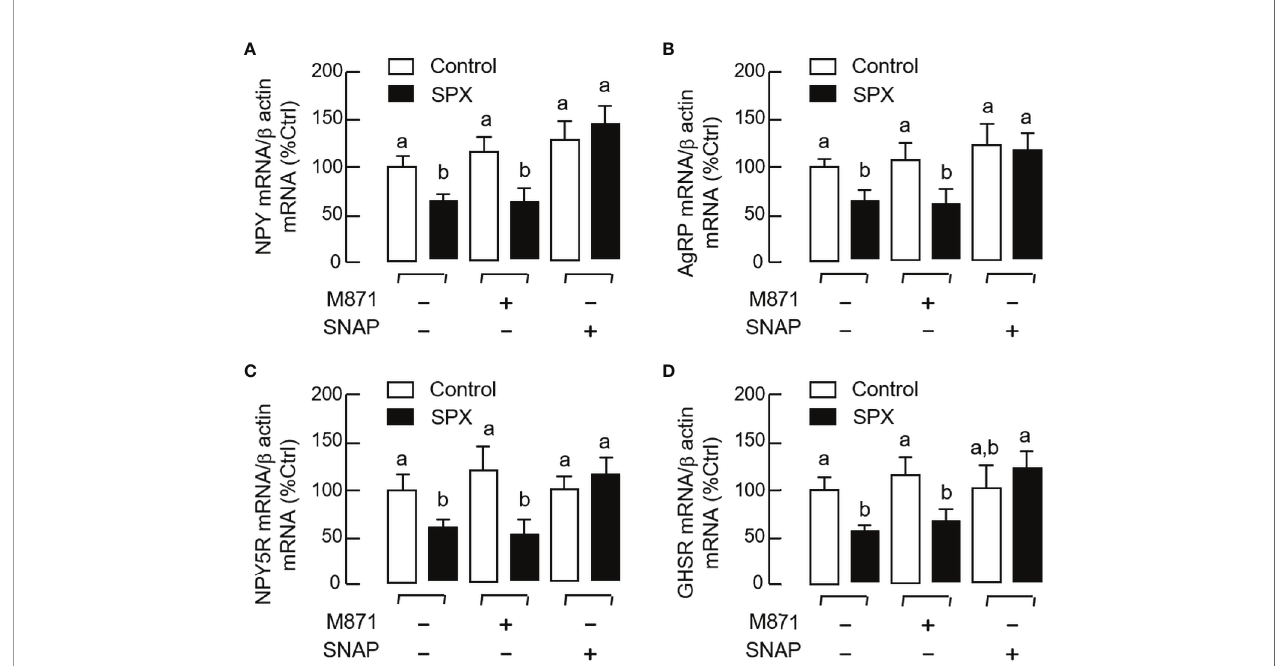
FIGURE 5 | Receptor speci fi city for SPX regulation of hypothalamic expression of orexigenic factors and their receptors. IP injection of SPX (5 nmol/mouse) was performed in mice with/without the co-treatment of the GalR2 antagonist M871 (50 nmol/mouse) or GalR3 antagonist SNAP (50 nmol/mouse). The hypothalamus was harvested one hour later after IP injection. Total RNA was isolated and subjected to real-time PCR for transcript expression of NPY (A) , AgRP (B) , NPY5R (C) and GHSR (D) , respectively with b actin mRNA as internal control. The groups denoted by different letters represent a signi fi cant difference at p <